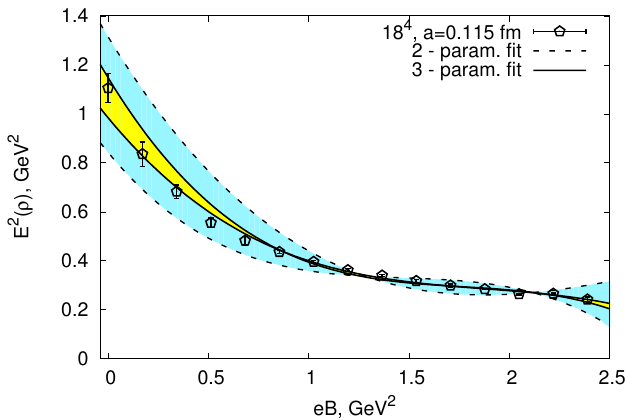
Figure 10. The energy squared of the ground state of the (cid:26) (cid:6) mesons with the spin projection s z = (cid:6) 1 versus the (cid:12)eld value for the lattice spacing a = 0 : 115 fm, the lattice volume 18 4 and the pion mass 395(6) MeV. The solid curves restrict the area obtained using the 3-parametric (cid:12)t (4.2) at the (cid:12)xed value of the g -factor. The dashed lines are the boundary of the acceptable E 2 values if the g -factor and (cid:12) m have the de(cid:12)nite values.